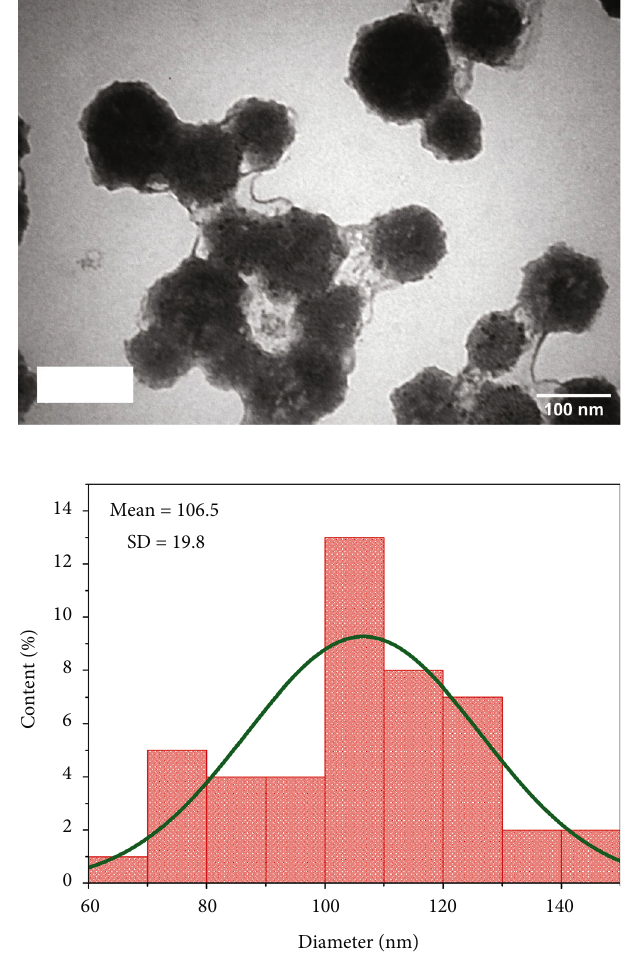
Figure 6: TEM of Fe